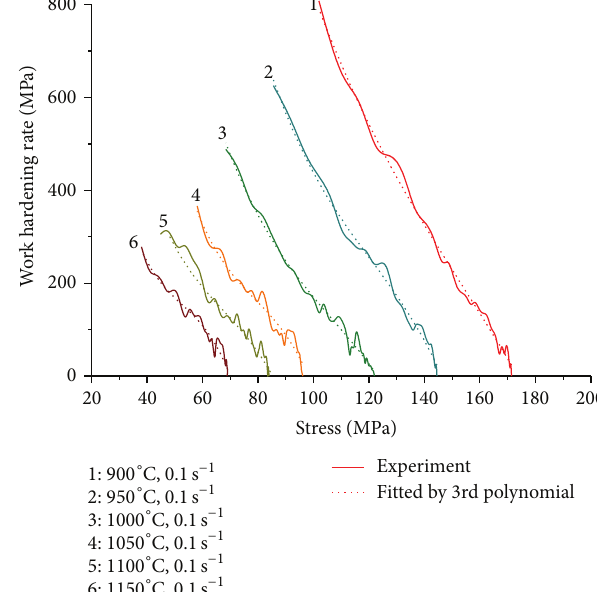
Figure 9: The 𝜃 - 𝜎 curve and its corresponding third order polyno-